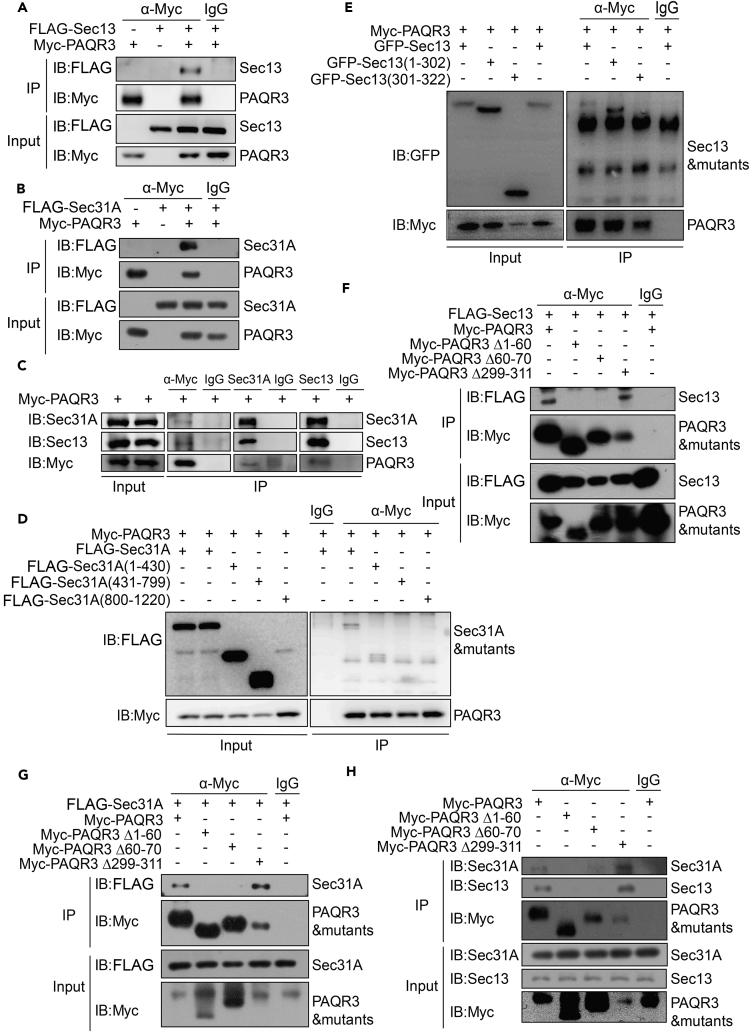
PAQR3 Interacts with COPII Components through its N-Terminal Region(A and B) Interaction of PAQR3 with ectopically expressed Sec13 and Sec31A. HEK293T cells were transiently transfected with Myc-tagged PAQR3, FLAG-tagged Sec13, and FLAG-tagged Sec31A as indicated. At 24 hr after the transfection, the cell lysate was used in immunoprecipitation (IP) and immunoblotting (IB) with the antibodies as indicated.(C) Interaction of PAQR3 with endogenous Sec13 and Sec31A. Myc-tagged PAQR3 was expressed in HEK293T cells. After transfection for 24 hr, the cell lysate was used in IP and IB with the antibodies as indicated.(D and E) Identification of the structural domain of Sec13 and Sec31A involved in the interaction with PAQR3. HEK293T cells were transiently transfected with PAQR3 and various mutants of Sec13 and Sec31A as indicated, followed by IP and IB analyses.(F–H) Identification of the domain of PAQR3 involved in the interaction with Sec13 and Sec31A. HEK293T cells were transiently transfected with various PAQR3 mutants and FLAG-tagged Sec13 or FLAG-tagged Sec31A as indicated. The cell lysate was analyzed by IP and IB with the antibodies as indicated. All the western blotting experiments were repeated at least twice with similar results.